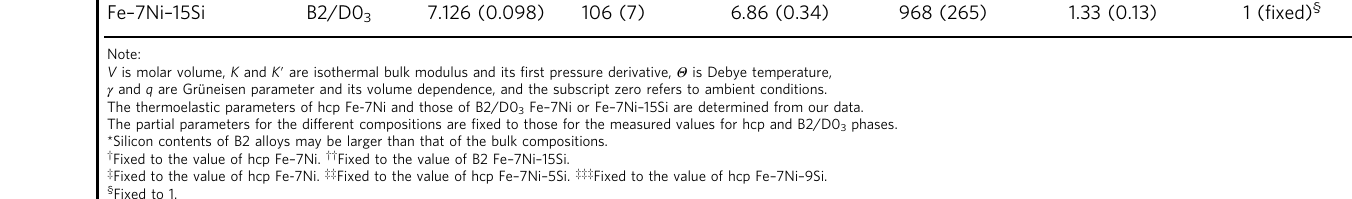
Fig. S1c, d. For a C Bulk of 5 and 7 wt%, the averaged v p slightly deviates from that of PREM (the C Bulk of 6), but it is within the error range. Although the v p of the two-phase mixture is not